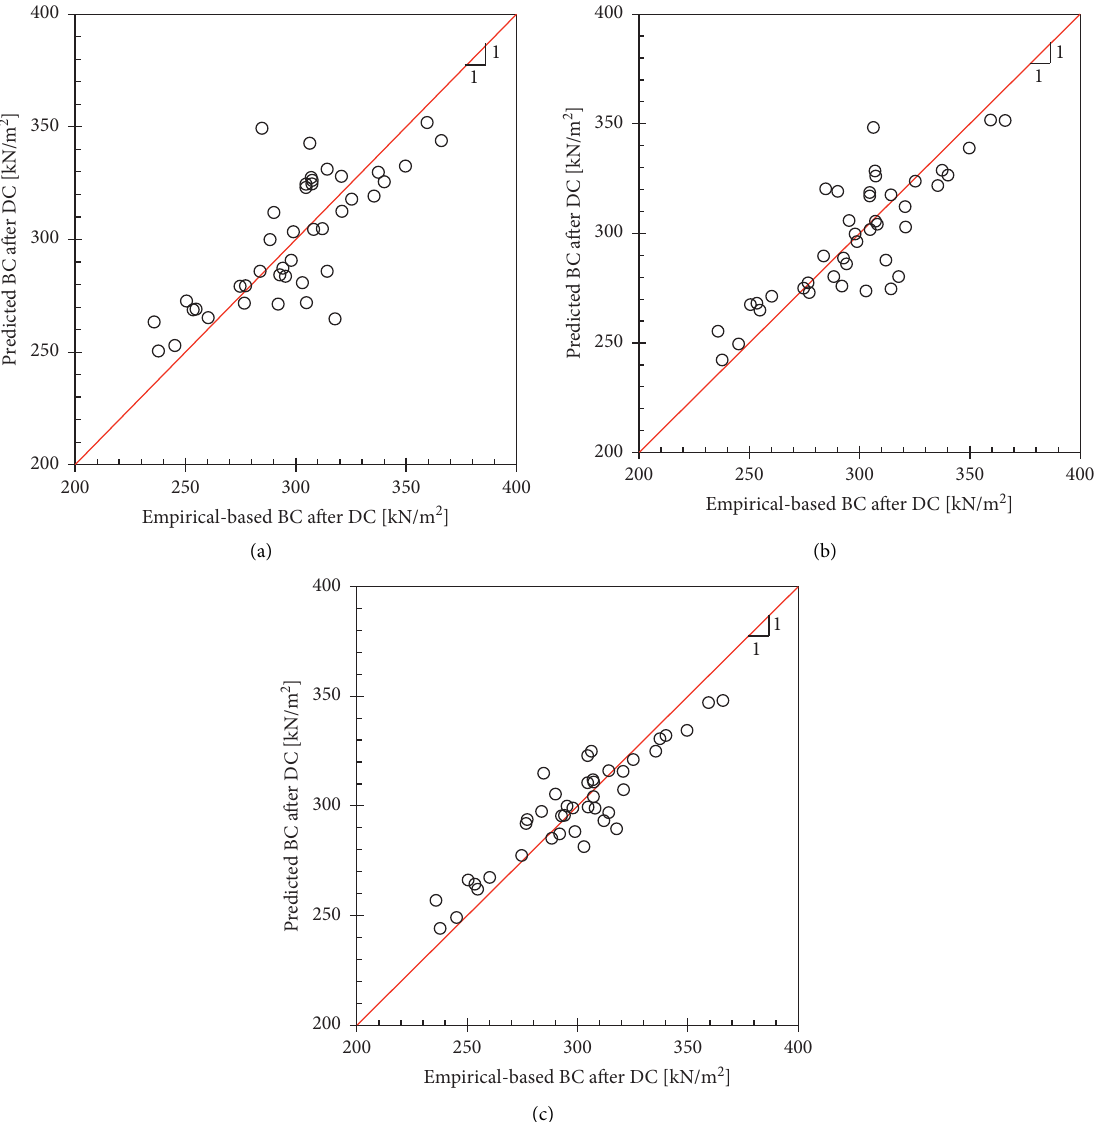
Figure 7: Cross-validation results - Machine learning-based predicted bearing capacity (BC) after dynamic compaction (DC) versus empirical-based BC after DC. The bearing capacity prediction uses machine learning spatial interpolation models. (a) Random forest using coordinates (RFC), (b) random forest using vector distances (RFVD), and (c) random forest using the nearest observations and their distances